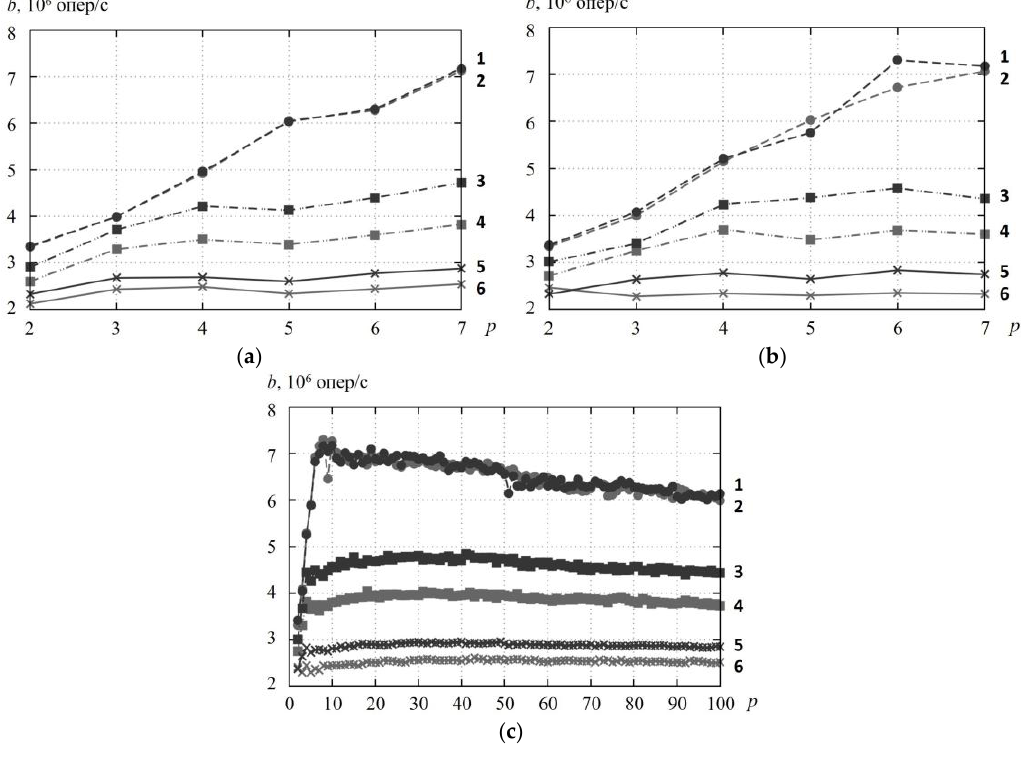
Figure 5. Efficiency of the algorithms for RCL-lock initialization on the Oak cluster. ( a ) p = 2, …, 7, thread affinity corresponds to Figure 4; ( b ) p = 2, …, 7, no thread affinity; ( c ) p = 2, …, 100. 1— RCLLockInitNUMA, sequential access, 2—RCLLockInitDefault, sequential access, 3— RCLLockInitNUMA, strided access, 4—RCLLockInitDefault, strided access, 5—RCLLockInitNUMA, random access, 6—RCLLockInitDefault, random access.